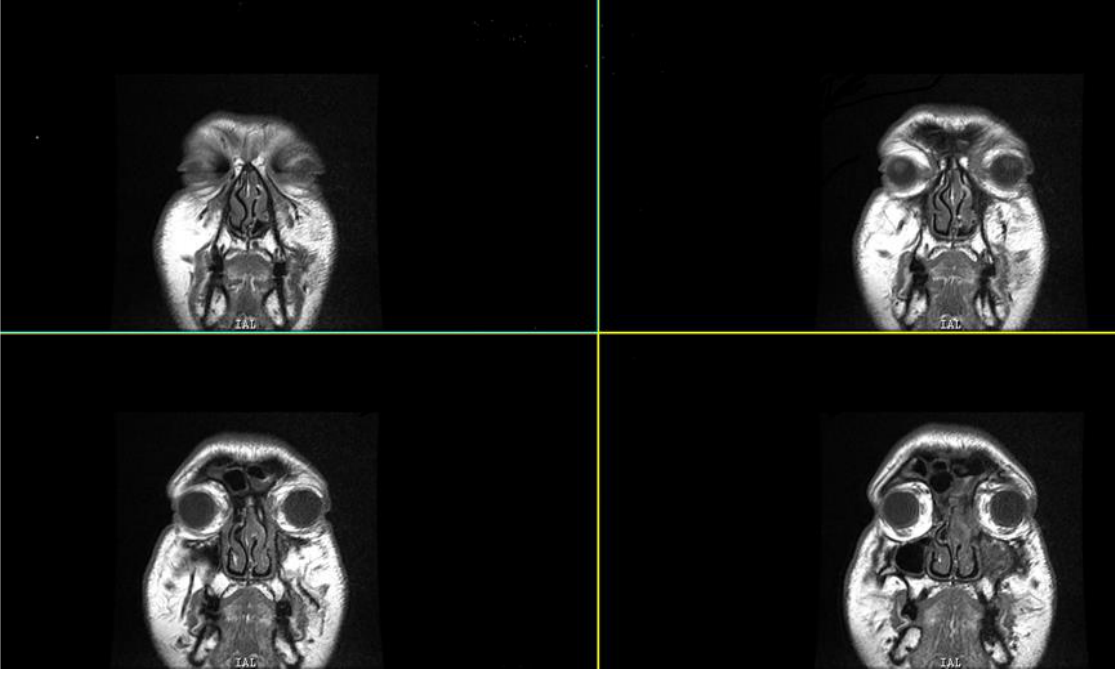
Figure 1. T1 coronal MRI showing hypointensity in the left maxillary, ethmoidal and frontal sinuses with breakdown of the left lamina papyracea.